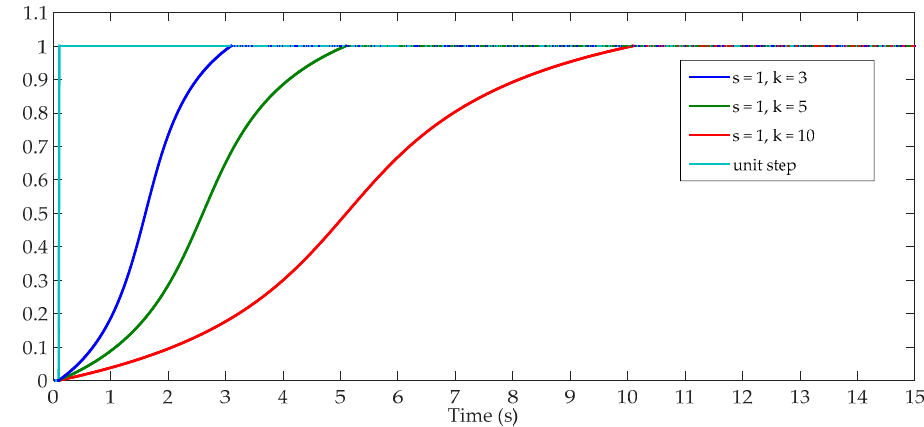
Figure 9. Filter time responses to unit step for different number of samples.